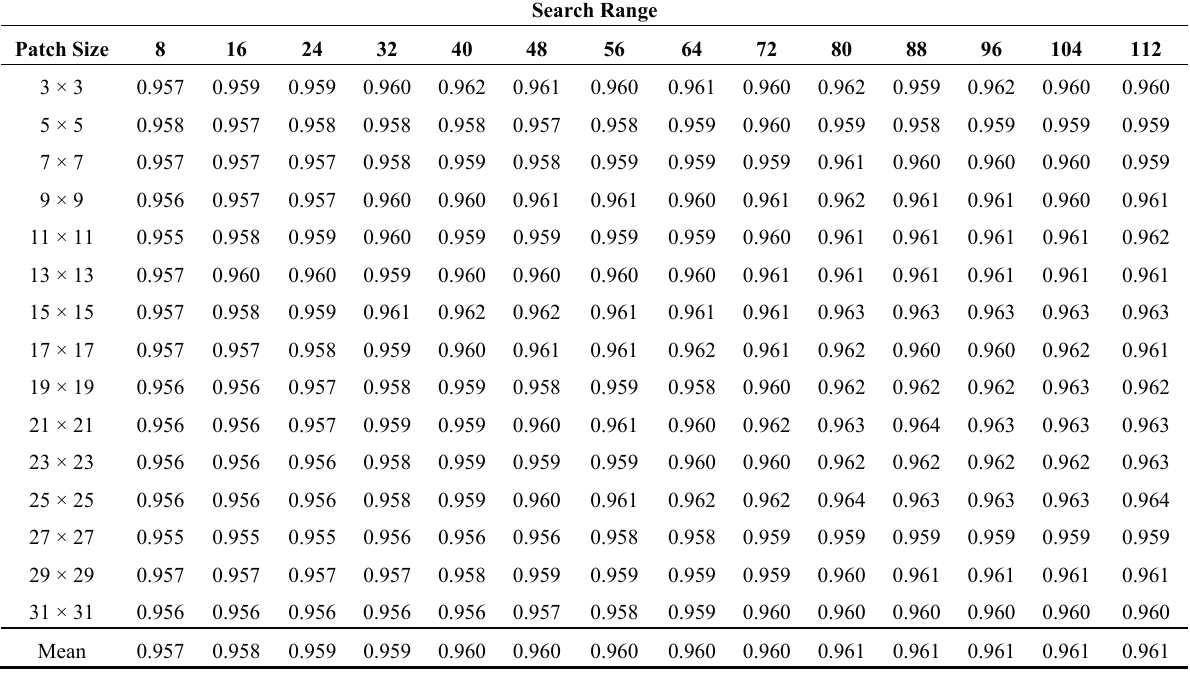
Table 6. Mean SSIM after denoising vs. search